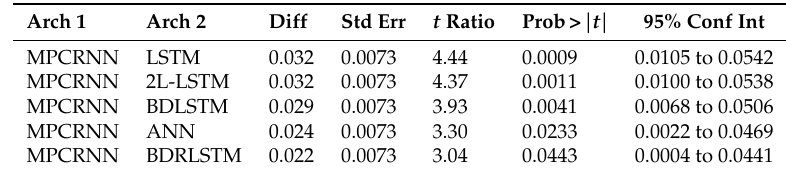
Table 9. Post-hoc Tukey HSD results between architectures, for the mean classification accuracy ANOVA. Only significant results are shown ( α =